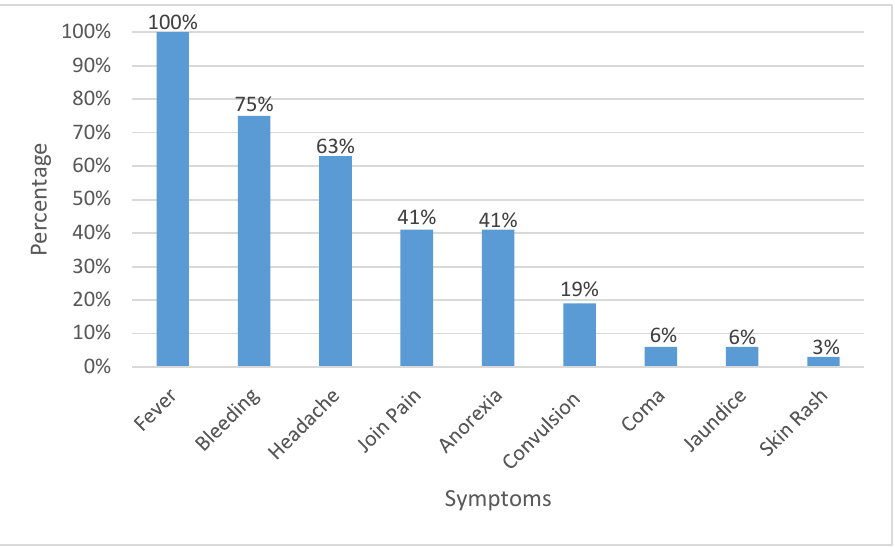
Figure 3. Clinical presentations of the confirmed cases of dengue fever.